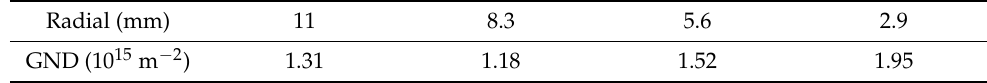
Table 4. GND of the forged tube with a reduction of 42.7%.